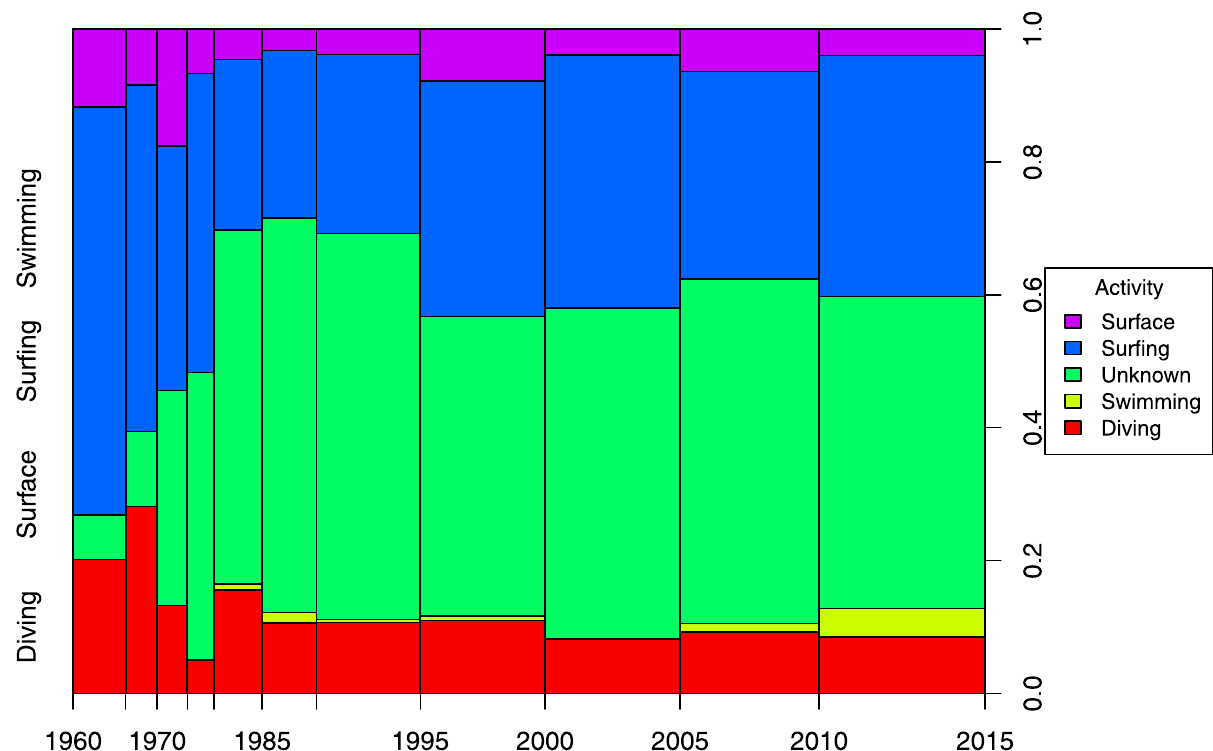
Fig 6. Proportion of shark attacks by victim activity over time from 1960–2015. (Diving includes Scuba diving, free diving and spearfishing; surface includes any surface or top water activities; surfing include boogie boarding and body boarding; swimming includes wading.) The widths of the 5-year periods are proportional to the sample size for the period, with thinner intervals indicating fewer samples (with 65 attacks for the period of 1975–1980 and 446 attacks for the period of 2010–2015, for